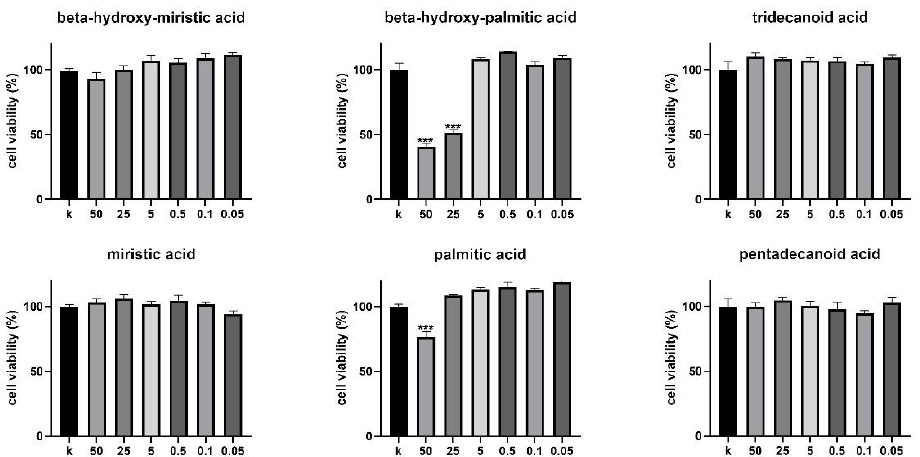
Figure 3. Cytotoxic effect of selected fatty acids on HeLa cells. MTT assay of HeLa cells treated with different concentrations of fatty acids (ranging from 50 to 0.05 µg/mL) for 24 h. Cell viability was expressed as % of control (K) (untreated cells), taken as 100%. Bars represent mean values, error bars represent SEM. *** p < 0.0001.